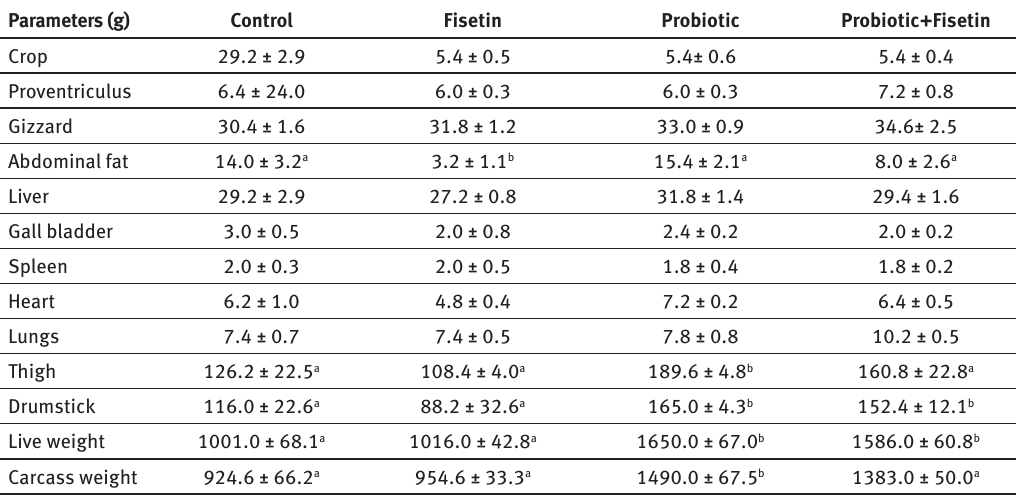
Table 5 Effects of probiotic and/or fisetin on carcass and organ weights of broiler